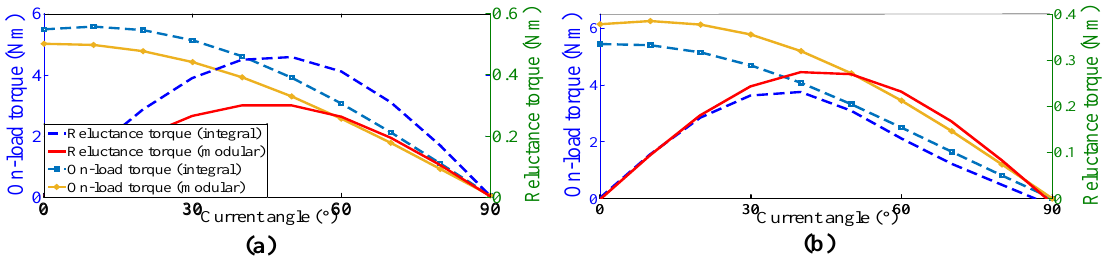
Figure 9. Reluctance and on-load torque versus current angles. ( a ) 12s/10p; ( b ) 12s/14p.